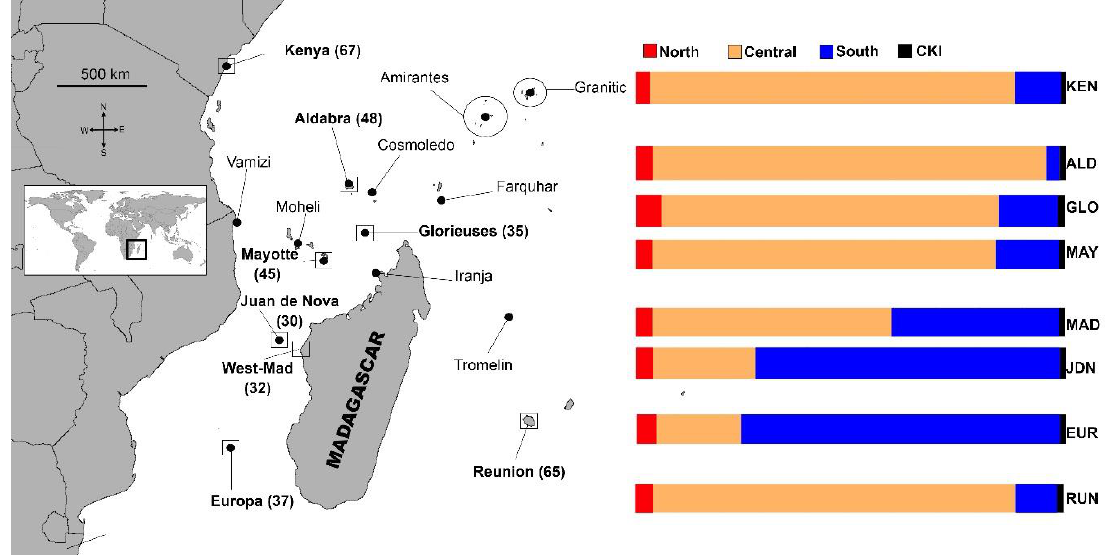
Figure 1. Location map. Locations of 15 green turtle ( Chelonia mydas ) nesting locations and eight foraging sites included in the mixed stock analysis (MSA). Black dots represent individual rookeries, and shaded squares define three genetically distinct groupings (stocks) used as our baseline. Foraging locations are represented by squares. The bar graph shows the mean relative contribution of North ; Granitics and Amirantes, Central ; Kenya, Aldabra, Cosmoledo, Vamizi, Mohéli, Mayotte, Glorieuses, Iranja and Tromelin; South ; Juan de Nova and Europa and CKI , Cocos (Keeling) Islands , to each of the eight developmental sites (CKI not shown on the map). The 95% confidence interval (CI) can be found in Table 2. Estimates are based on the mixed stock analysis using the many-to-many package in “R”, and using the population size as weighted priors. Table 1. Frequencies of 13 mitochondrial DNA D-loop haplotypes (385 bp) found in eight juvenile Chelonia mydas foraging sites thoughout the Southwest Indian Ocean (SWIO). Also shown is haplotype (Hd) and nucleotide ( π ) diversity for each foraging site. Shaded area shows "orphan" haplotypes that have not yet been recorded at a nesting site.